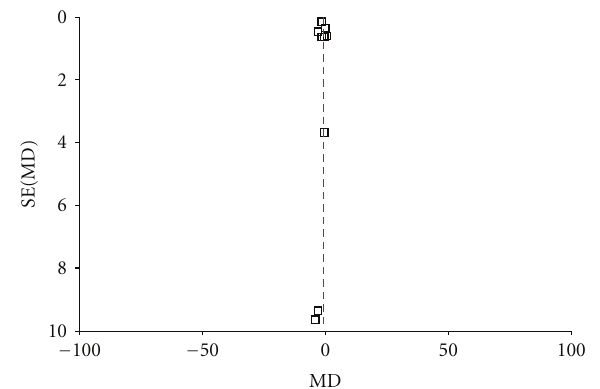
Figure 3: Funnel plot of the mean di ff erence in body weight reduction trials of HCA, plotted against sample size. The vertical line depicts the weighted mean di ff erence of all